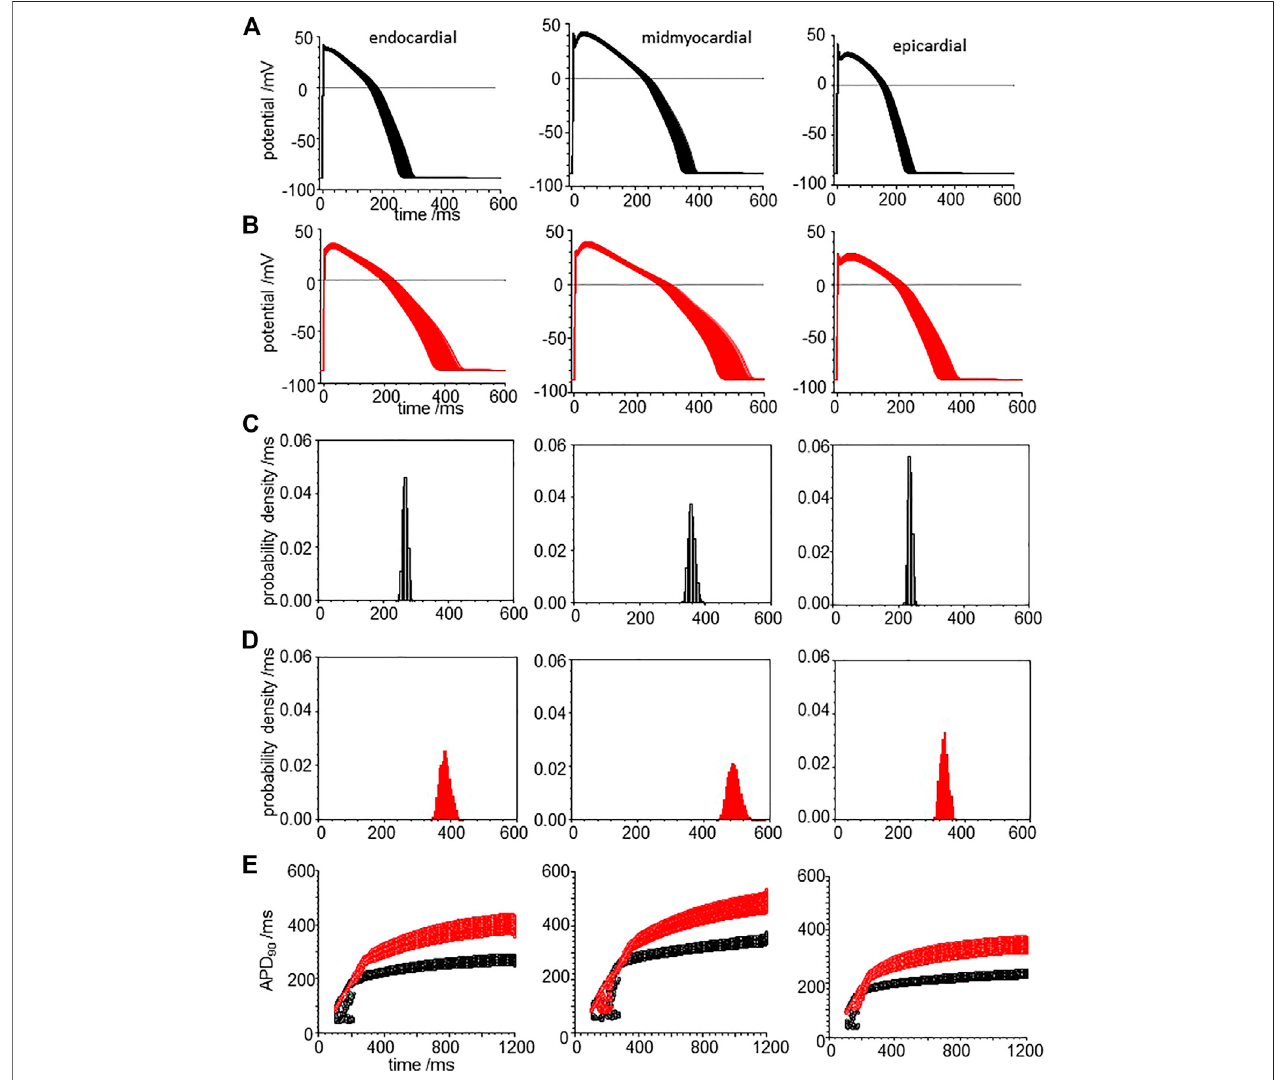
FIGURE 8 | CO prolongs APD90 and increases its variability in ORd (2011) human ventricular endocardial, midmyocardial and epi-myocardial cell models. 1,000 actionpotentialsatBCLof1 S(100thactionpotentialatBCLof1 s) (A) forstandardmodel (B) COmodelwithallthecurrentmagnitudeparametersGaussiandistributed with a 5% standard deviation. Probability density estimates for APD 90 ‘ s of action potentials of (C) standard model and (B) CO model. (E) 32 superimposed dynamic restitution curves for cell models, with the conductance parameters distributed as above. Red: with CO parameters, black standard parameters.